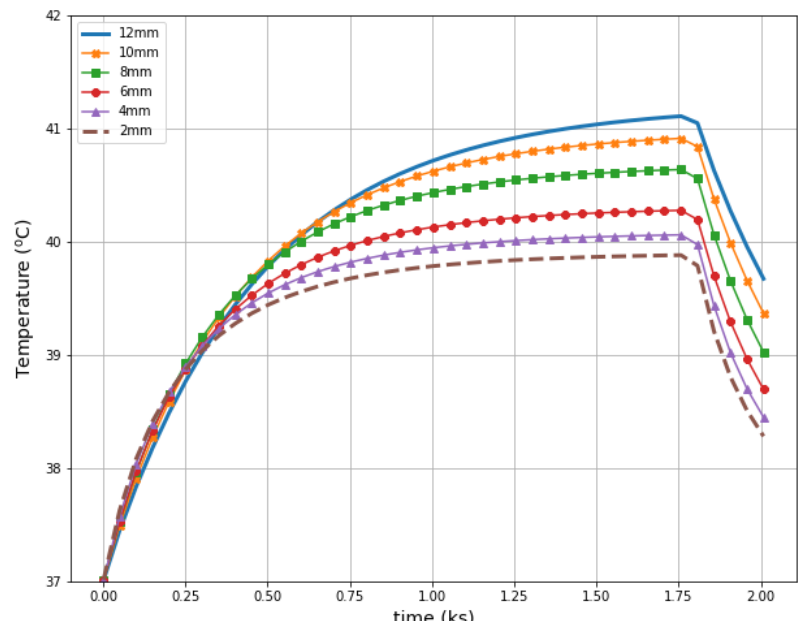
Figure 11. The transient temperature distributions inside the tumors subjected to the eight-dipole antenna array after the optimization procedure.